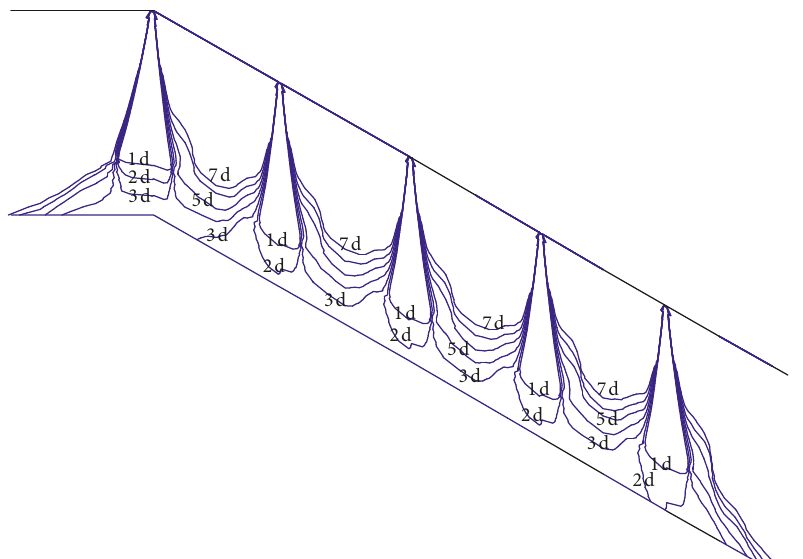
Figure 14: The distribution of the phreatic line with the rainfall time when the fracture density is 5 (fracture depth 3